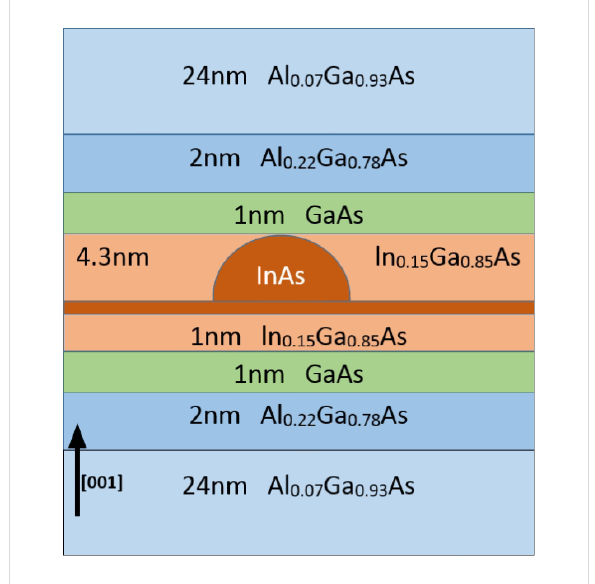
Figure 1: A schematic of the measured and simulated QD system. The dimensions of the simulated structure are 60 nm × 60 nm × 60 nm. The quantum dot is dome-shaped InAs with a base diameter of 20 nm and a height of 5 nm, with a wetting layer of two monolayers. The strain control layer of In 0.15 Ga 0.85 As is sandwiched between two 1 nm layers of GaAs, and two 2 nm layers of Al 0.22 Ga 0.78 As. The rest of the structure is made of Al 0.07 Ga 0.93